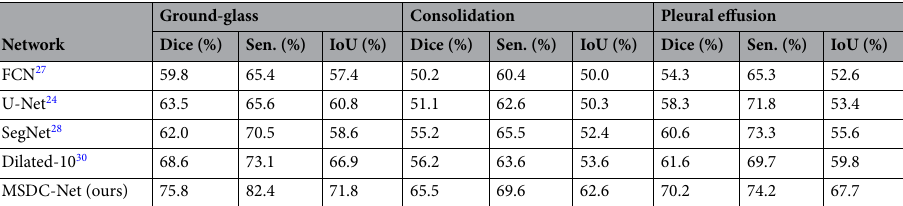
Table 5. Comparison of performances on different types of infections (ground-glass, consolidation and pleural effusion).